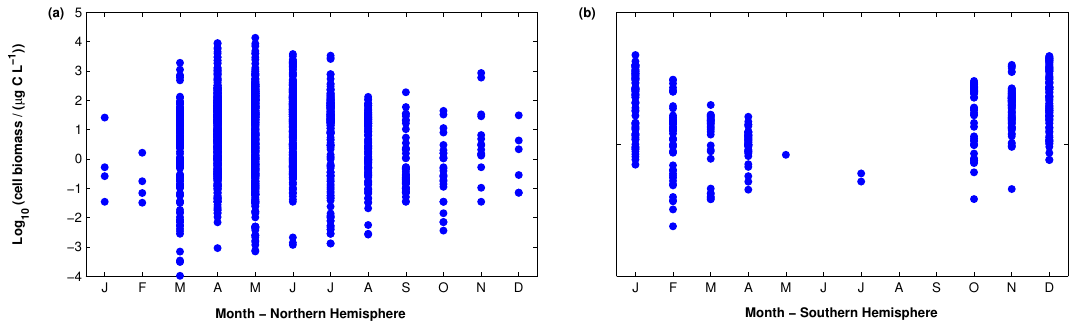
Figure 8. Seasonal distribution of log-normalized non-zero Phaeocystis cell biomass data for (a) the Northern and (b) the Southern Hemispheres.